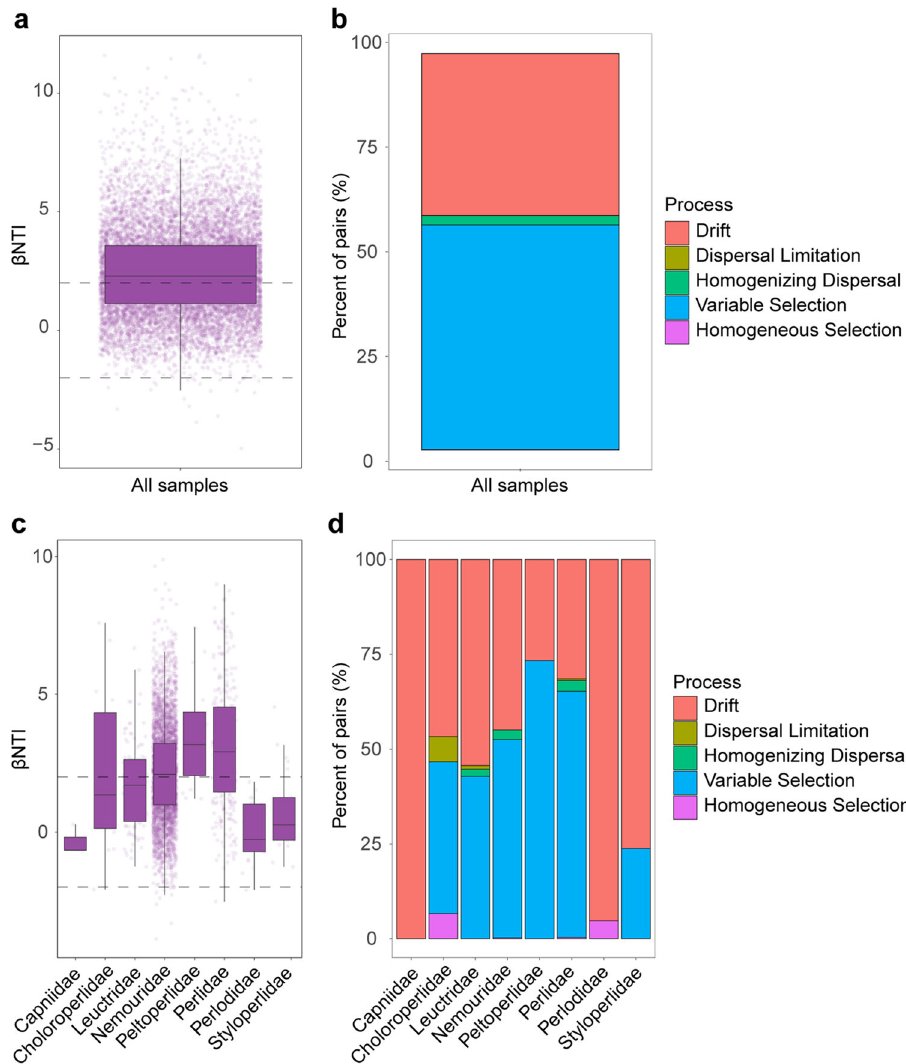
Fig. 6 Mechanisms of stone fl y fungal community assembly evaluated using null model analysis. Contributions of deterministic (| β NTI | ≥ 2) and stochastic processes (| β NTI | < 2) on fungal community assembly in all stone fl ies ( a ) and in each of eight stone fl y families ( c ). The relative contribution of ecological processes (i.e., homogeneous selection, heterogeneous selection, homogenizing dispersal, dispersal limitation, and drift) in driving the fungal assembly in all samples ( b ), and in each stone fl y family ( d